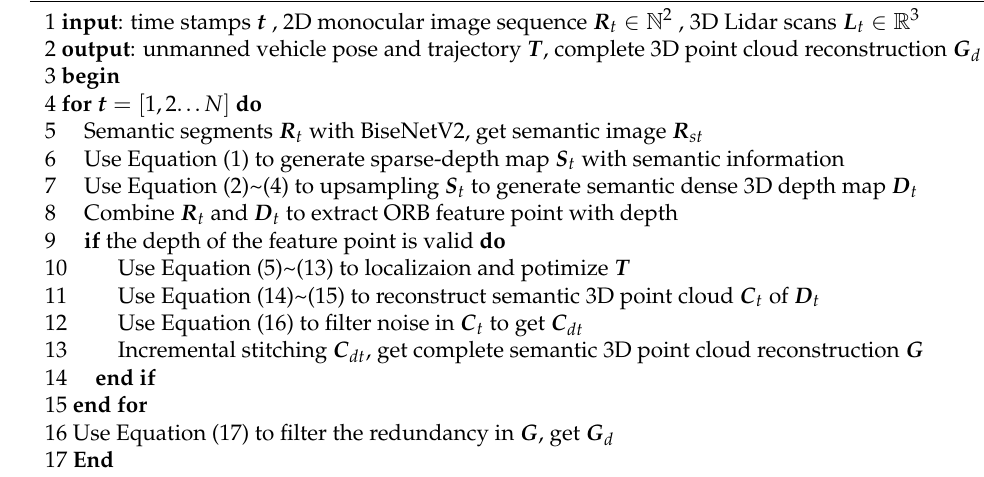
Algorithm 1 : SLAM and 3D semantic reconstruction based on the fusion of Lidar and monocular vision.